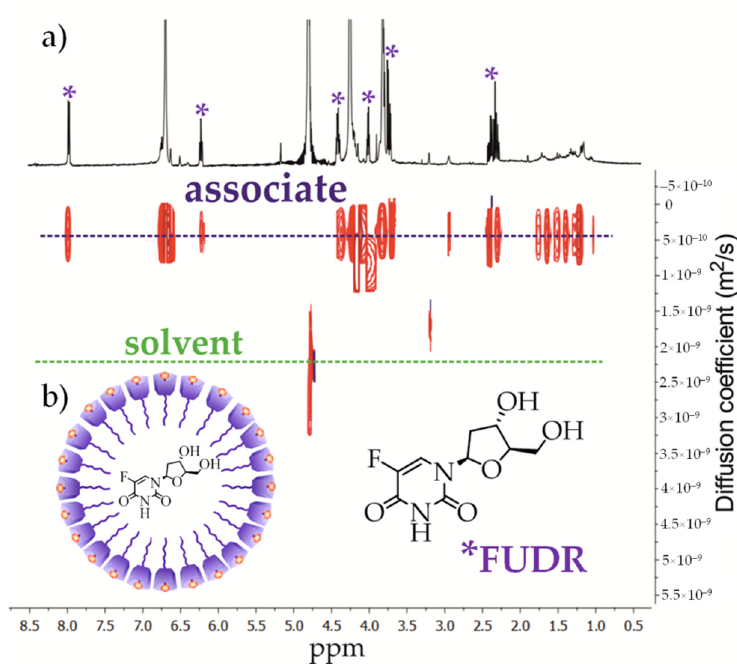
Figure 9. ( a ) 2D DOSY NMR spectrum 3a / 5/ FUDR (1 × 10 − 3 M) in D 2 O (400 MHz, 298K), 298K, ( b ) schematic picture of the 3a/5 /FUDR associate.